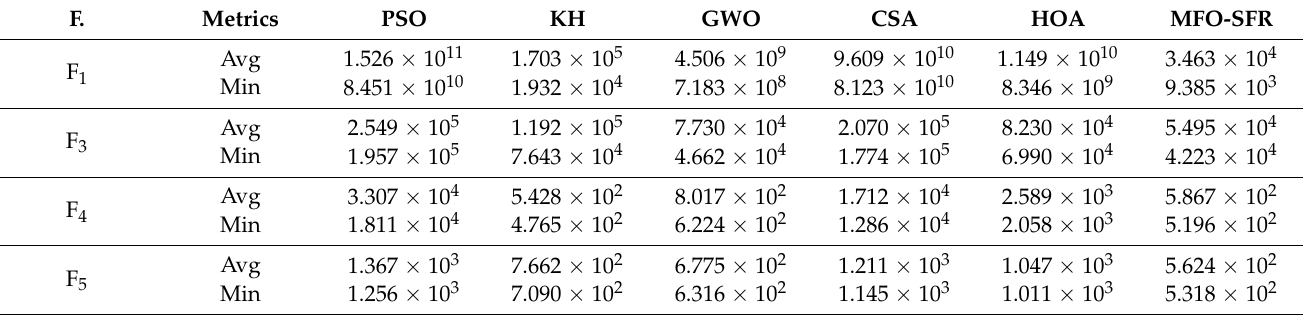
Table 6. Comparison of MFO-SFR with well-known algorithms for CEC 2018 test functions with D =